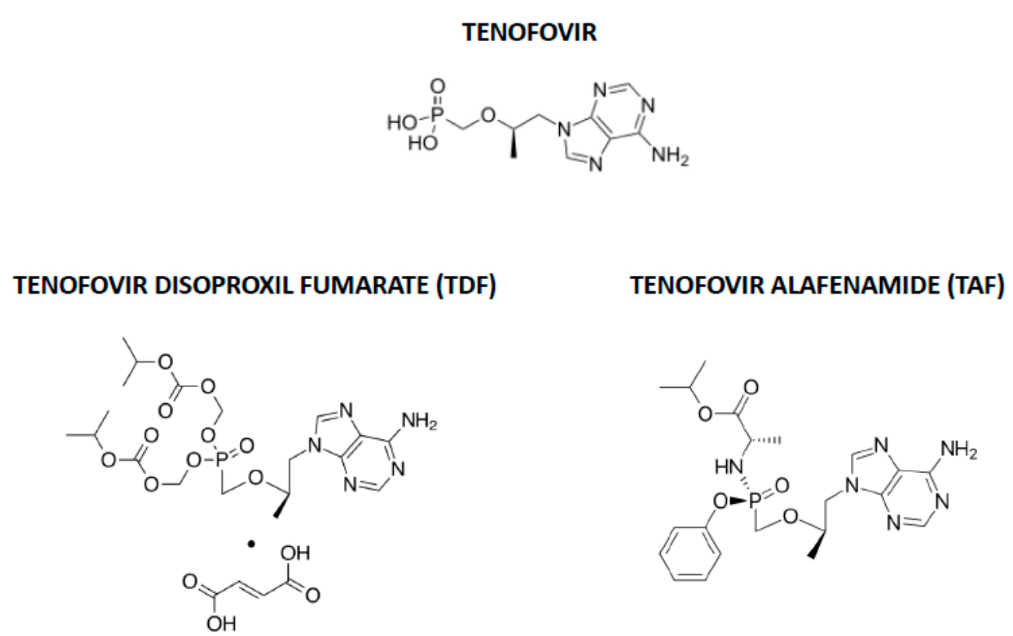
Figure 2. Chemical structures of tenofovir, tenofovir disoproxil fumarate (TDF) and tenofovir alafenamide (TAF).